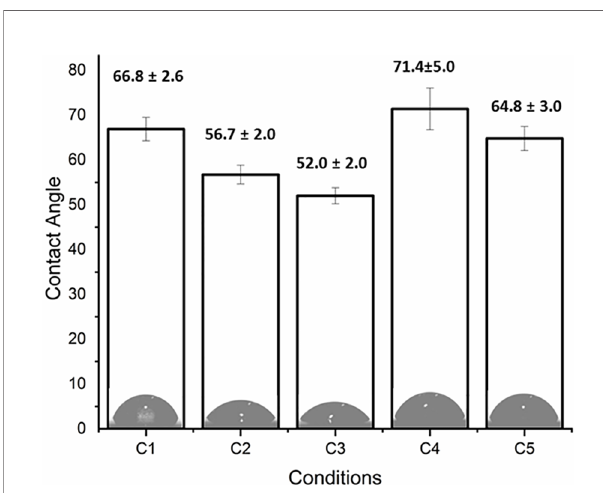
FIGURE 2 | Contact angle measurements and water drop images on the sample ’ s surfaces.